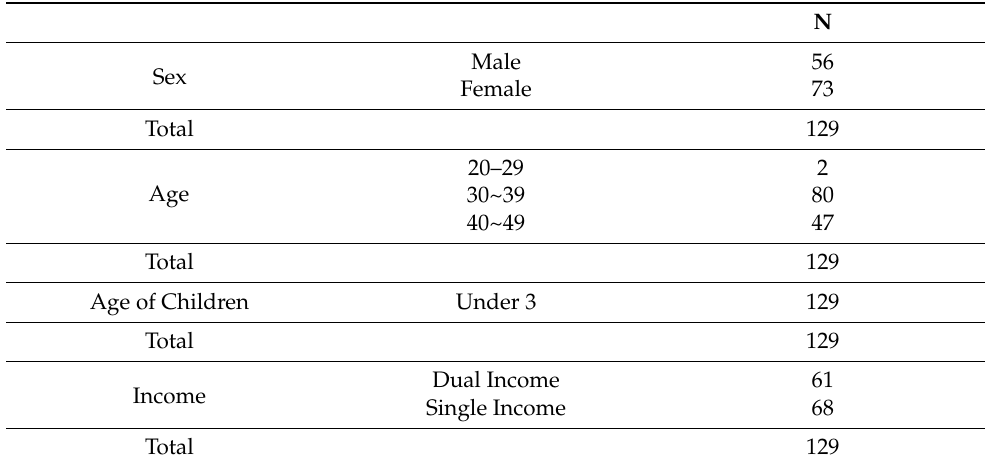
Table 1. Study 1 sample distribution.